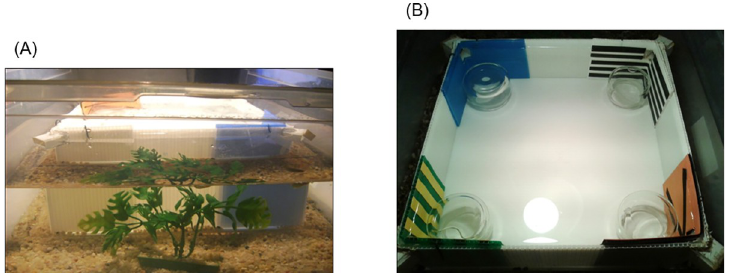
Fig 3. Square experimental arena for the reference memory task. (A): External view of the square apparatus used for reference memory tasks ( Experiment 3 and 4 ): A plastic square tank, with four small corridors embedded in the four corners, was inserted in a larger tank and a surrounding comfortable area for fish (with gravel, plants, conspecifics and food) became an incentive to leave the apparatus. (B): Photographic enlargement of the square apparatus used for the reference memory procedure with panels ( Experiment 3 ) and blue wall ( Experiment 4 ): It is clearly visible the position of corridors into the corners. The presence of the glass jars kept the visual layout the same as Experiment 2 .